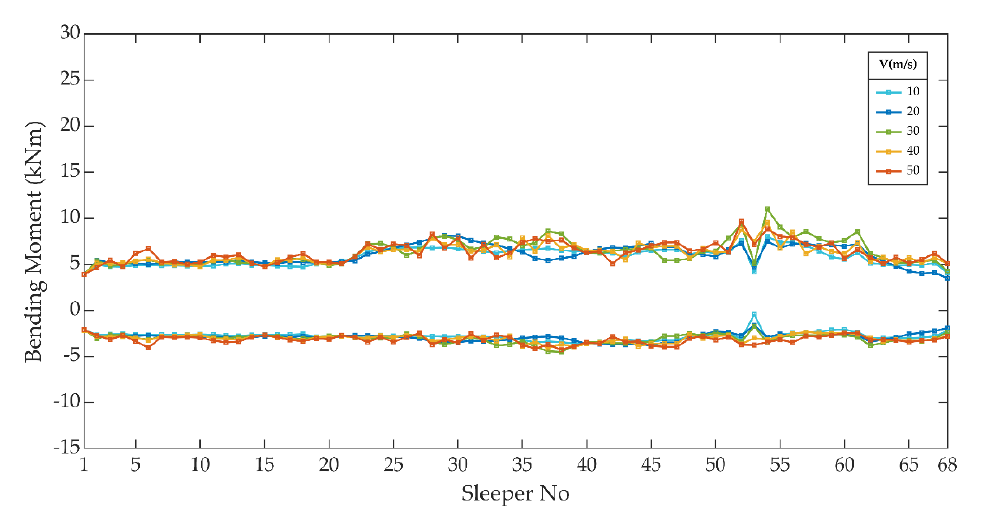
Figure 30. Maximum bending moments of the FFU bearers when one bearer under crossing nose is unsupported.